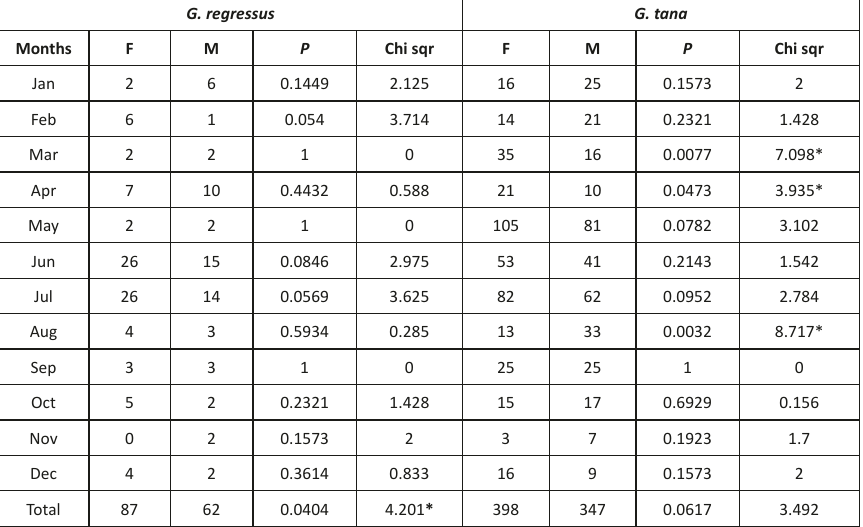
Table 3. Number of female and male fish, sex ratio (F:M) and the probability ( P ) of getting calculated chi-square value for Garra regressus and G. tana in the collected monthly samples from Lake